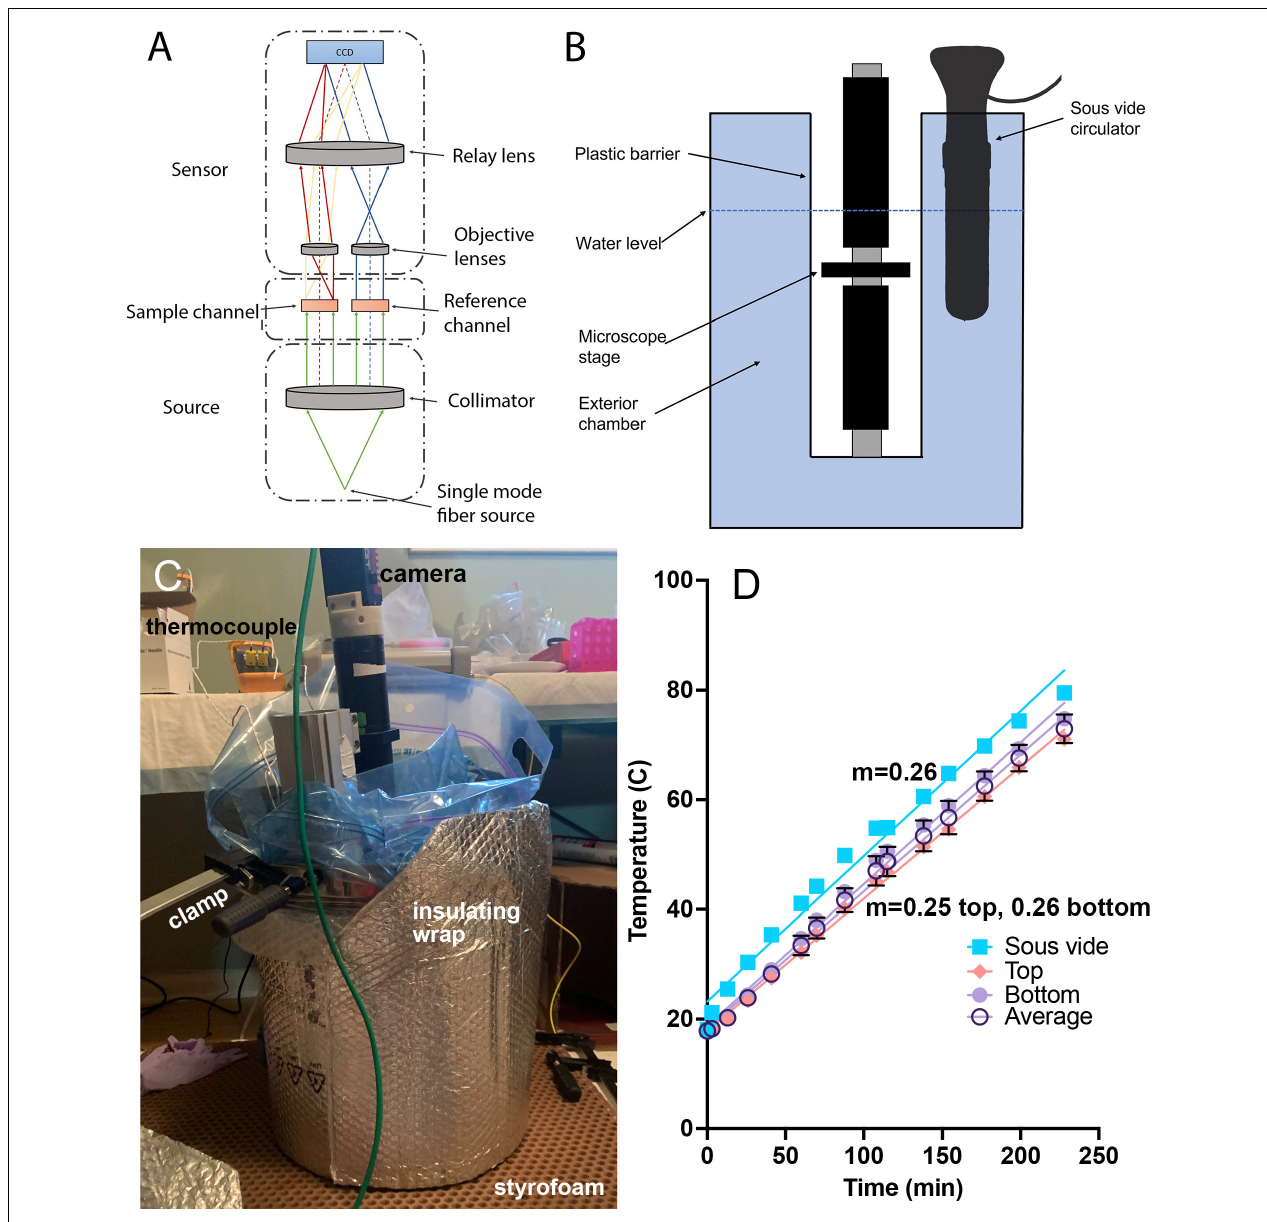
FIGURE 1 | Temperature-controlled microscope setup. (A) Schematic of off-axis DHM used in these experiments. (B) The microscope was protected by a heavy-duty plastic bag and submerged in heated water to control the sample temperature. (C) Photograph of the complete setup showing the insulating materials necessary to attain the highest temperatures. The microscope is submerged into the pot with the sample chamber located several cm below the water surface. The insulation shown is required for achieving water and sample temperatures above ∼ 70 ◦ C. (D) Correspondence between the sous vide measured water temperature (verified with a laboratory thermometer) and thermocouple measurements of the sample chamber at top and bottom, along with the average between top and bottom. The slope of the temperature change was consistent between the bath and the chamber, with a nearly constant offset of 5 ◦ C. The lines are linear fits with slopes